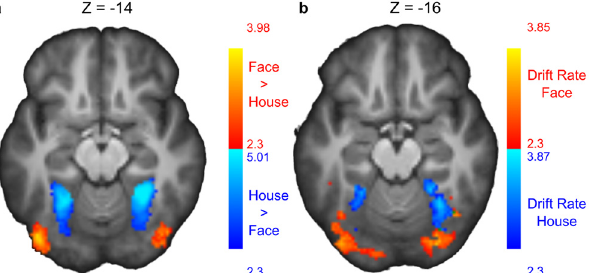
Fig 4. Face and House cluster activations. (A) Cluster activations for face > house (red) and house > face (blue) contrasts collapsed across response conditions. (B) Clusters positively correlated with drift rates estimated for each subject across difficulty levels. Green indicates overlap of clusters. All contrasts were thresholded at Z > 2.3 with whole-brain correction for multiple comparisons at p < 0.05.